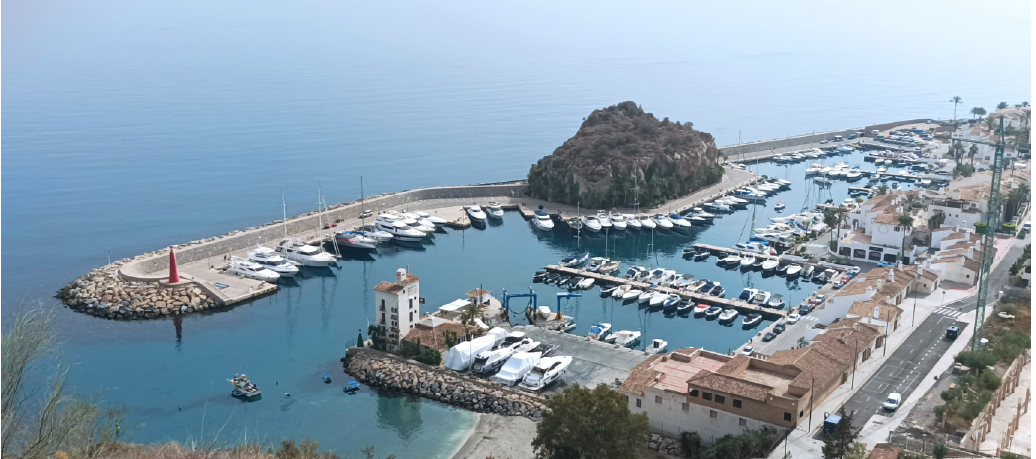
Figure 2. General view of Marina del Este with Peñón de las Caballas as a structuring element (photograph by authors, October 2022).